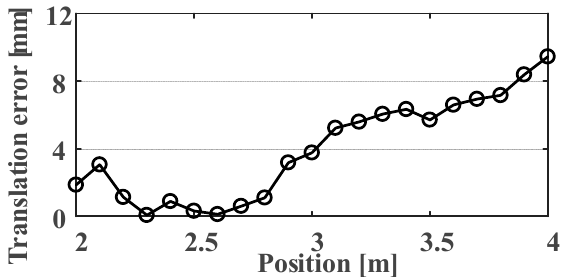
Figure 14. Translation error along the Z -axis at 2 to 4 m.